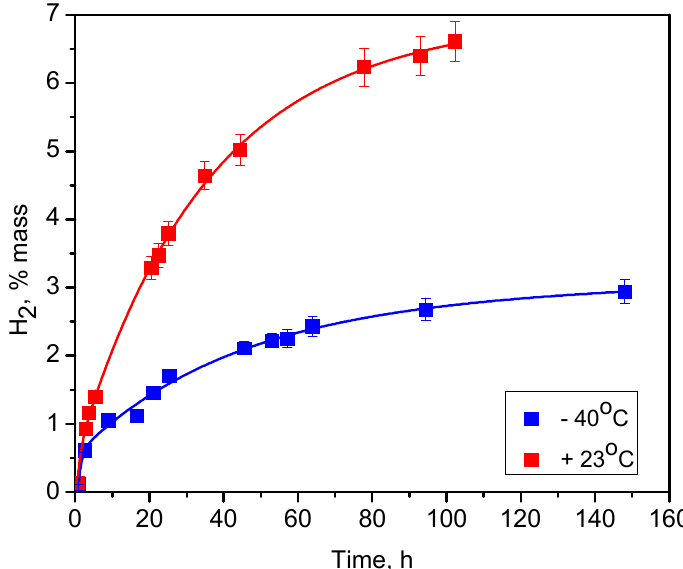
Figure 4. Kinetics of hydrogen generation due to oxidation reaction of meso-PSi nanopowders in water:ethanol solutions at different temperatures. Discrete points correspond to experimentally measured values, while solid lines are the fitting functions given in Supplementary Materials. The values on y-axis correspond to the percentage mass of H 2 related to the mass of the reacted PSi nanopowder and water, which is necessary for the reaction.